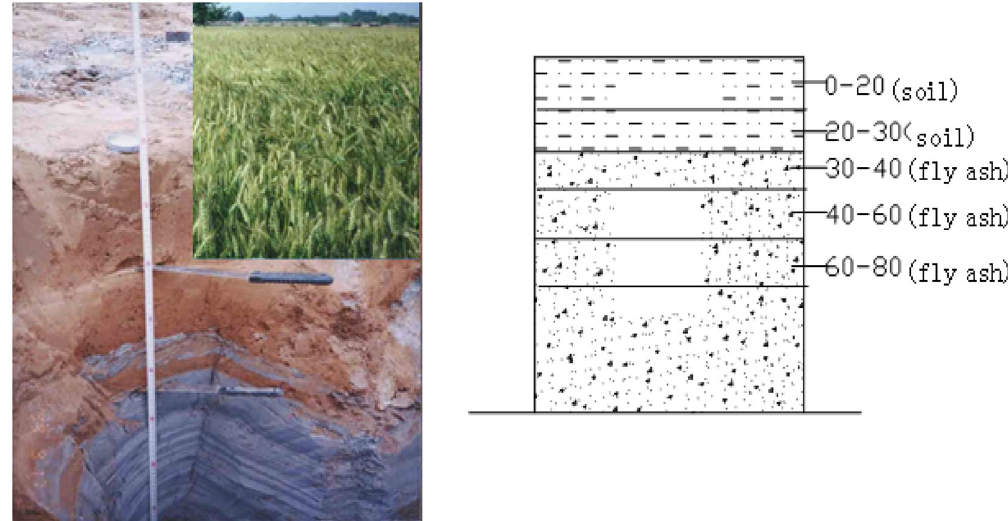
Fig. 2 Profile of reconstructed soil with CFA at Pingdingshan, Henan Province, China (in the upper right side of the picture wheat crop on the reconstructed